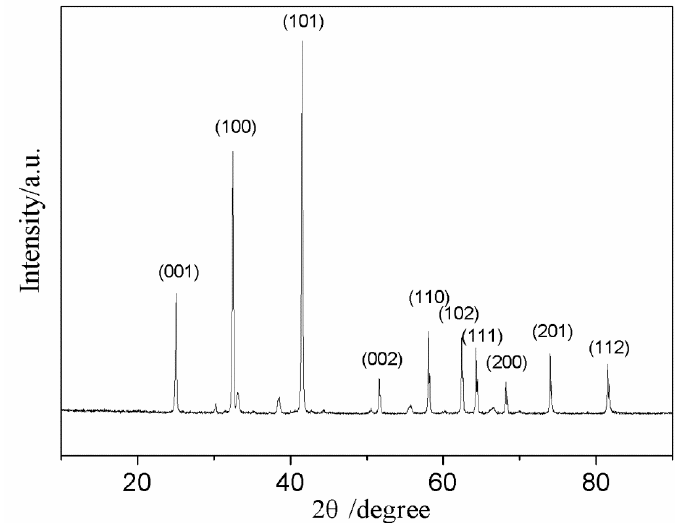
Figure 5. XRD pattern of the sample obtained when the mole ratio of B / Zr was set at 2.0. Fig ure 5. XRD pattern of the sample obtained when the mole ratio of B/Zr was set at 2.0. The di ff raction peaks of (001), (100), (101), (002), (110), (102), (111), (200), (201), and (112) of a face-centered cubic (fcc) ZrB 2 (JCPDS 00-034-0423) can be clearly observed in the XRD pattern